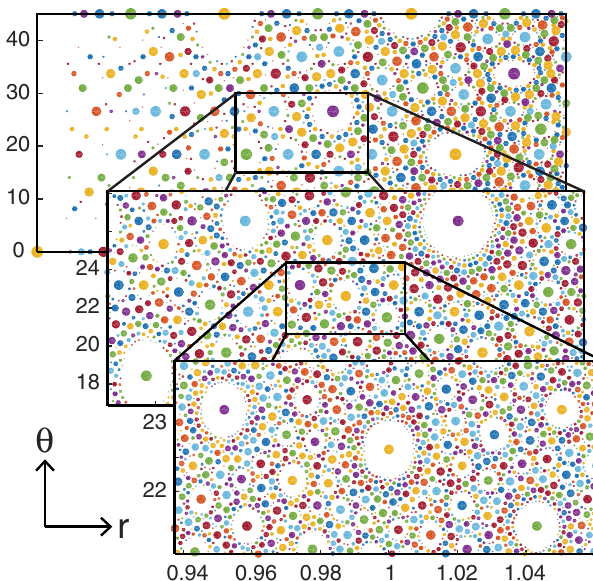
Fig. 1 Fractal arrangement of periodic systems. Sequential insets zooming into smaller regions of parameter space. Dots identify Moiré parameter ( r , θ ) values corresponding to systems with periodic microgeometry, where short and large periods are identi fi ed by large and small dots, respectively, revealing self similar, fractal arrangements of periodic